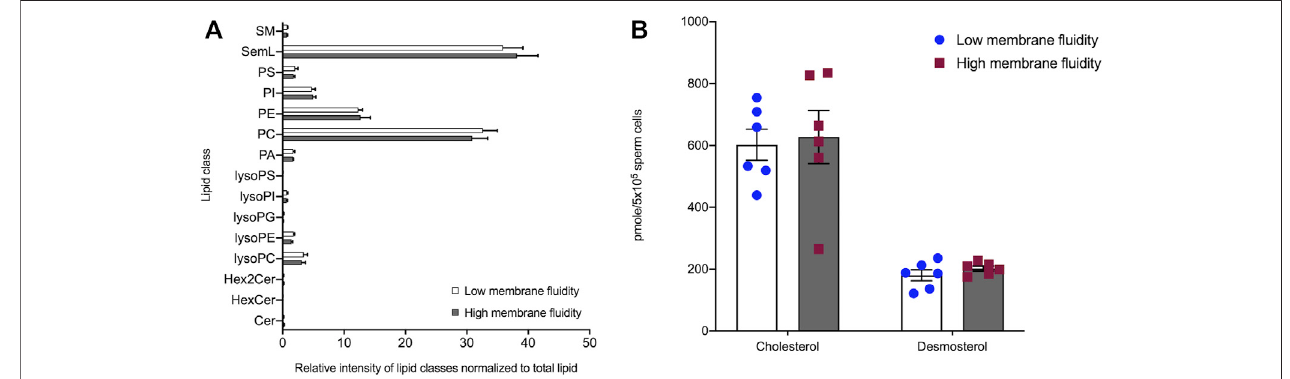
FIGURE5| Lipidomicanalysisofstallionspermpopulationswithlow-andhigh-membrane fl uidityselectedbyFACS-sorting.Stallionspermatozoawereincubated for 60 min in either Tyr Control or Tyr BIC medium supplemented with Hoechst 33258. Fifteen minutes prior to FACS sorting M540 was added to each population. Using a FACS In fl ux, stallion sperm cells were sorted into two subpopulations; viable sperm with low membrane fl uidity (Hoechst negative, M540 “ low ” ); and viable sperm with highmembrane fl uidity(Hoechstnegative,M540 “ high ” ).Sampleswerethenprocessedforeitherphospholipidandglycolipidanalysisorquantitationofcholesterol and desmosterol.Phospholipidand glycolipidanalysisrevealed 15classesofphospholipids presentinstallionspermatozoa (A) witharelativeabundanceofseminolipid (SemL)and phosphatidylcholine (PC). Nosigni fi cantdifferenceswerefoundbetweenspermatozoawithhigh membrane fl uidity orlowmembrane fl uidity ( n (cid:2) 6stallions). (B) Similarly,thecomparisonofcholesterolanddesmosterollevelsinlowandhighmembrane fl uiditypopulationsrevealednosigni fi cantdifferenceinmajorsterolcontent in stallion spermatozoa ( n (cid:2) 6 stallions). Abbreviations: SM, sphingomyelins; SemL, seminolipids; PS, phosphatidylserines; PI, phosphatidylinositols; PE, phosphatidylethanolamines; PC, phosphatidylcholines; PA, phosphatidic acids; lysoPS, lysophosphatidylserines; lysoPI, lysophosphatidylinositols; lysoPG, lysophosphatidylglycerols; lysoPE, lysophosphatidylethanolamines; lysoPC, lysophosphatidylcholines; Hex2Cer, dihexosylceramides; HexCer, hexocylceramides; Cer,